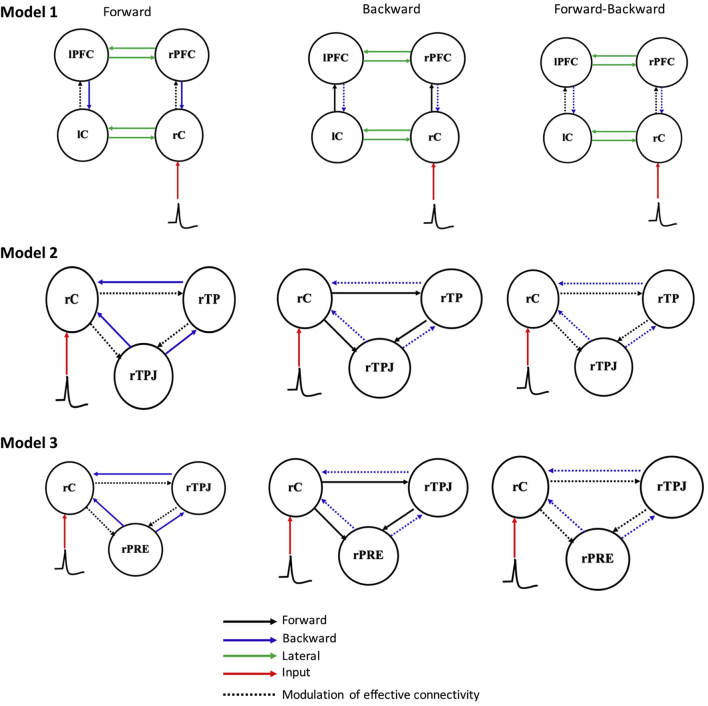
Model specifications. Three models were composed of three sub-models: forward (F), backward (B) and forward-backward (FB) models. The sources comprised the epileptic zone at the right central (rC), left central (lC), right temporal pole (rTP), right temporo-parietal junction (rTPJ), right and left prefrontal cortex (rPFC, lPFC) and right precuneus (rPRE). There are forward (black), backward (blue) and lateral (green) connections and the dotted line indicates the modulation of effective connectivity, i.e. changes in connection. (For interpretation of the references to color in this figure legend, the reader is referred to the web version of this article.)